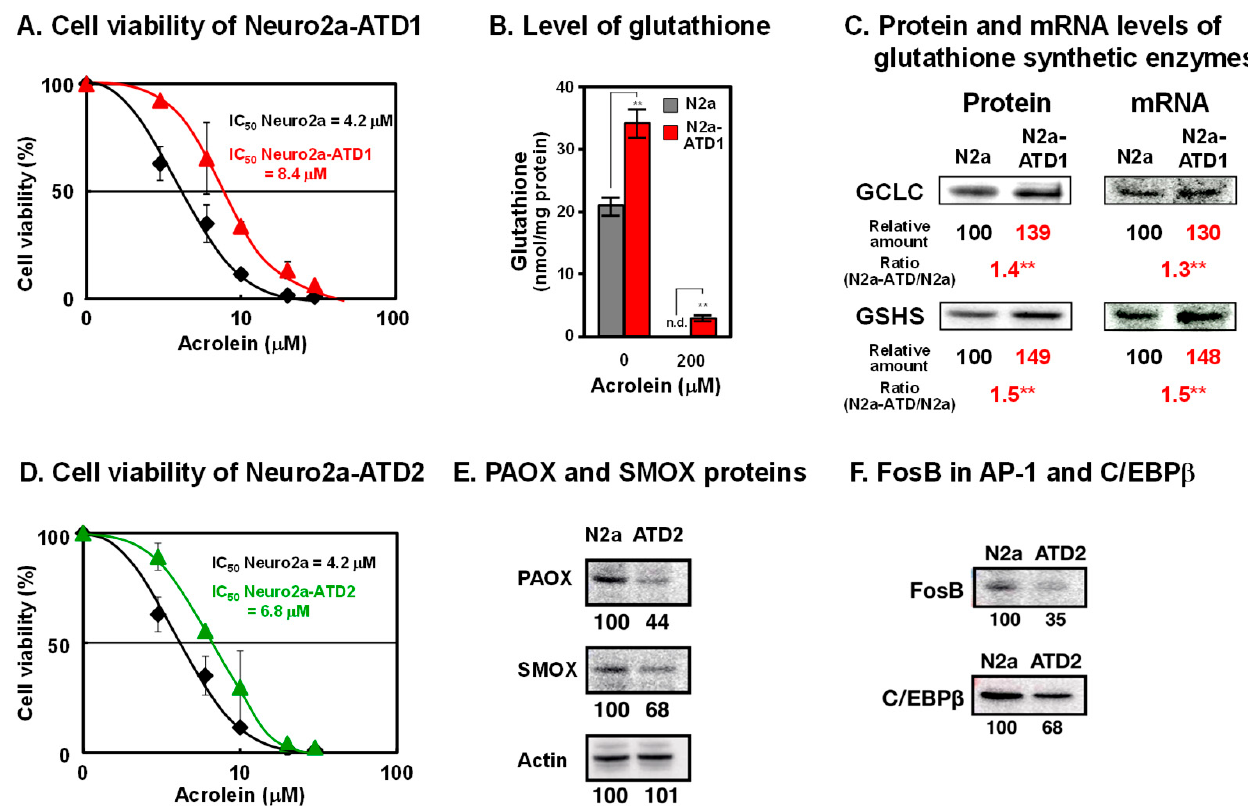
Figure 1. Characteristics of two cell lines of acrolein-toxicity-decreasing Neuro2a cells. ( A ). Cell viability of Neuro2a-ATD1. ( B ). Level of glutathione. ( C ). Protein and mRNA levels of glutathione synthetic enzymes. **, p < 0.01. ( D ). Cell viability of Neuro2a-ATD2. ( E ). Decrease in proteins of PAOX and SMOX in Neuro2a-ATD2. ( F ). Decrease in transcription factors involved in transcription of PAOX and SMOX in Neuro2a-ATD2. Adapted with permission from Refs. [24,25]. 2012 and 2016 Elsevier.